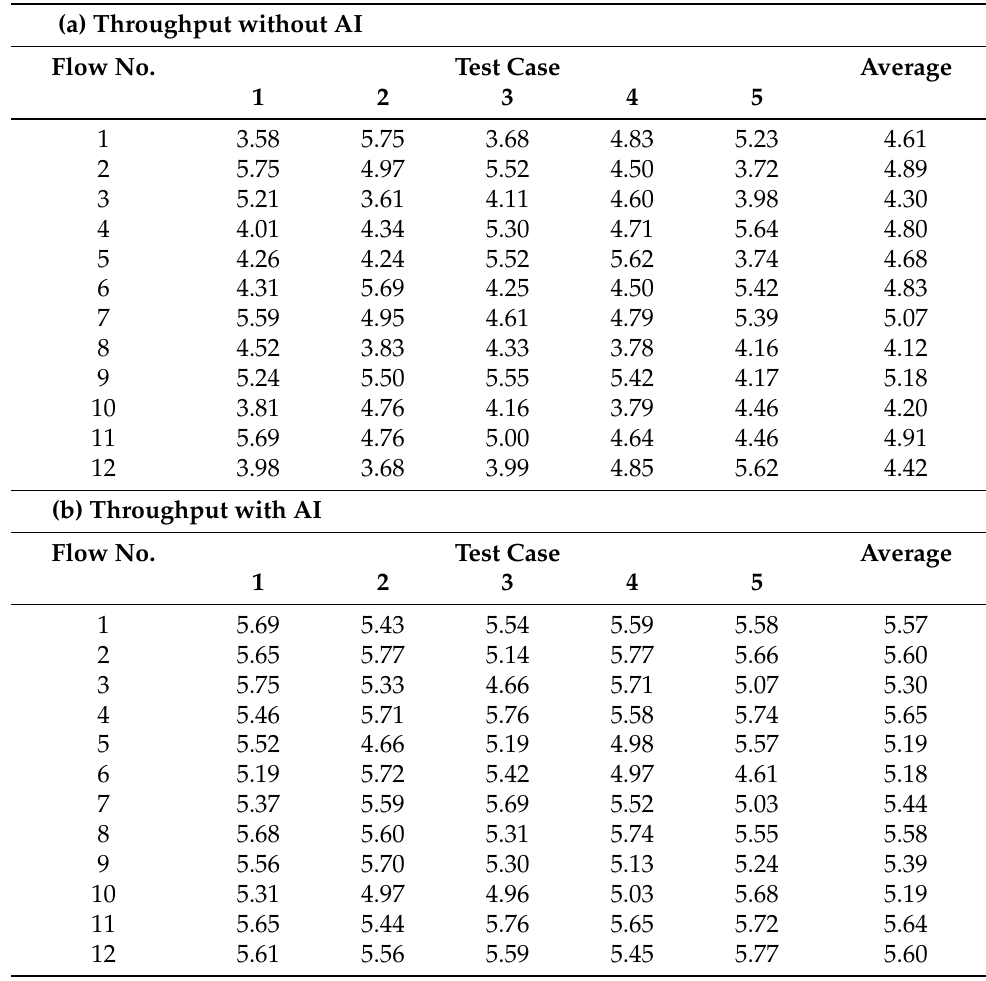
Table 1. Comparison of flows’ throughput for different test